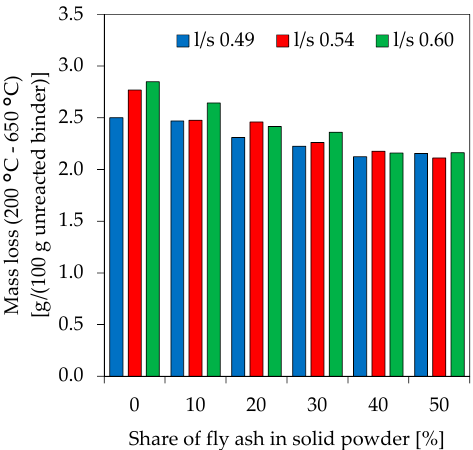
Figure 13. TGA (thermogravimetric analyzes) mass loss of geopolymers (temperature range 200 °C– 650 °C).